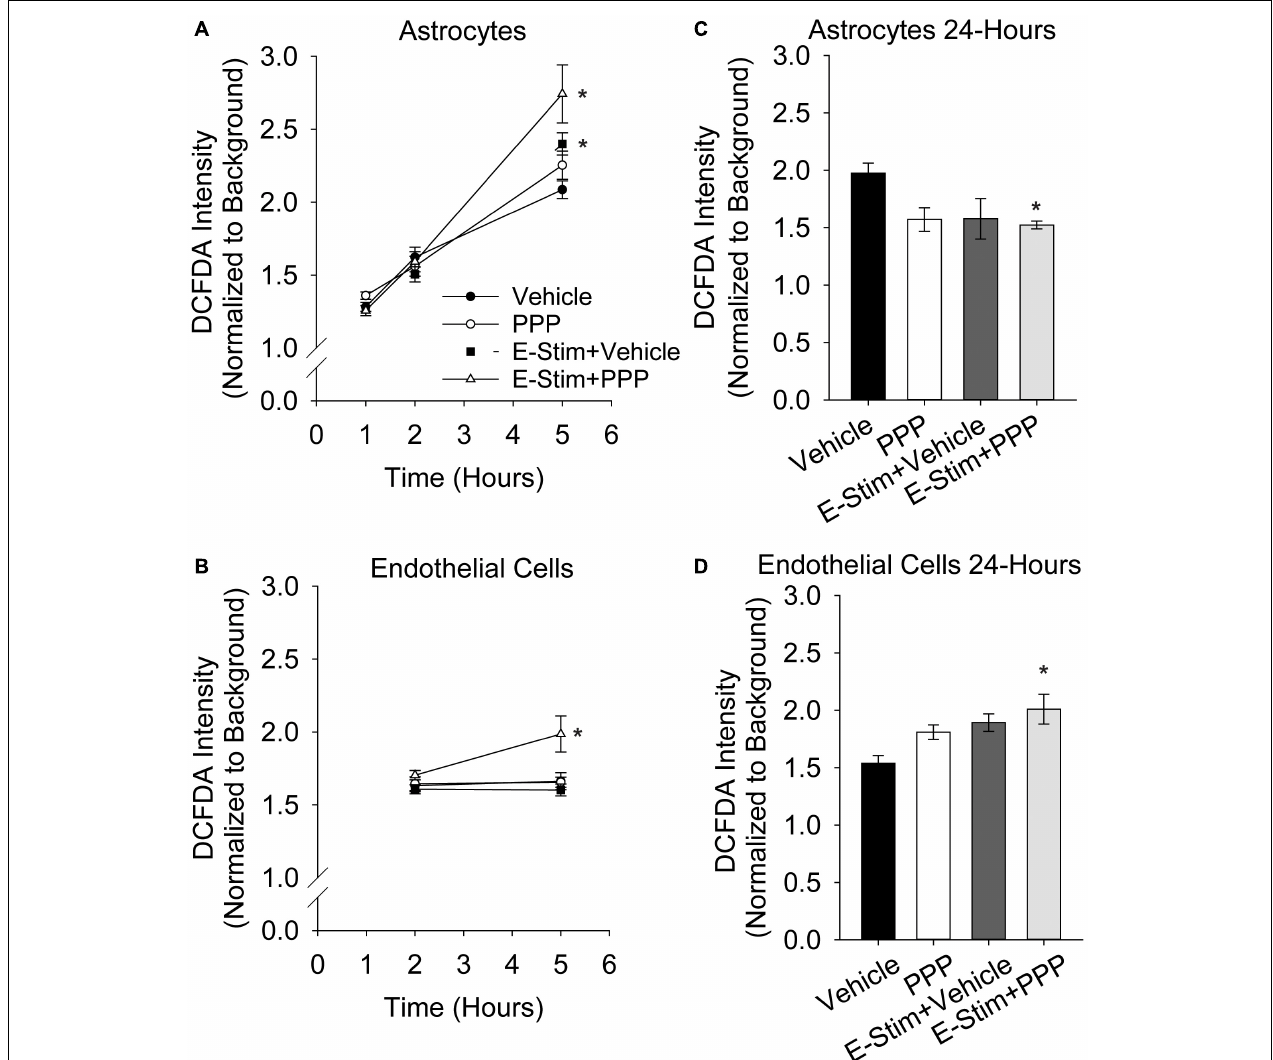
FIGURE 4 | Astrocytic and endothelial ROS levels are elevated by IGFR inhibition and glutamate stimulation. Average ROS levels in pure cultures of astrocytes (A) or endothelial cells (B) co-treated with 0.5 µ M PPP and 100 µ M glutamate for 1 h, and subsequently measured 1, 2, and 5 h after treatment. Four cells were selected at random per field, with 3 fields per well, and 8–10 wells per treatment group. Background intensity within each image was measured and used to normalize. A two-way ANOVA was employed with both time and treatment as factors, and a post hoc Holm-Sidak was used to compare within groups. * indicates a significant effect of treatment at that time. Average ROS levels in pure cultures of astrocytes (C) or endothelial cells (D) co-treated with 0.5 µ M PPP and 100 µ M glutamate for 1 h, and subsequently measured 24 h after treatment. Four cells were selected at random per field, with 3 fields per well, and 4–8 wells per treatment group. A one-way ANOVA with post hoc Dunnett’s test was used for statistical comparisons to control. * indicates a significant effect vs control. All data are presented as mean ±